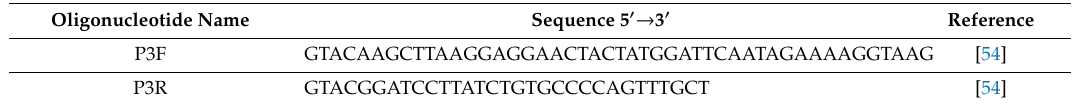
Table 3. Oligonucleotides used in this